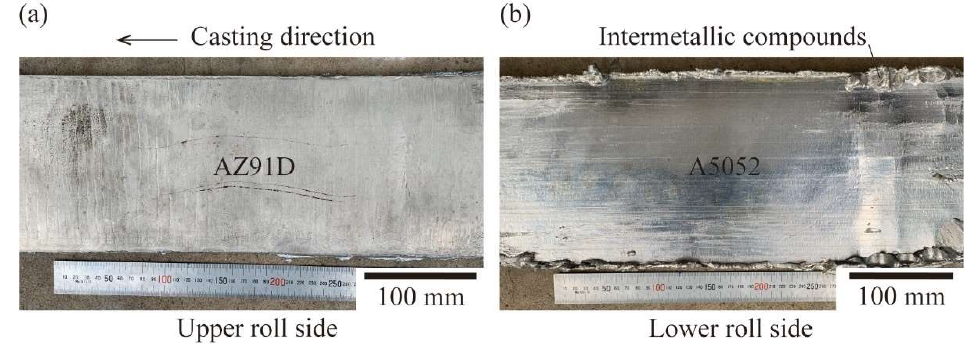
Figure 8. The surface of the AZ91D/A5052 clad strip with an upper solidification length of 100 mm. ( a ) Upper roll side, ( b ) Lower roll side.